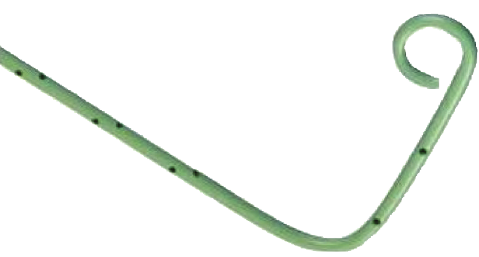
Figure 1: Seven French × 50 cm polyethylene drainage ring catheter.